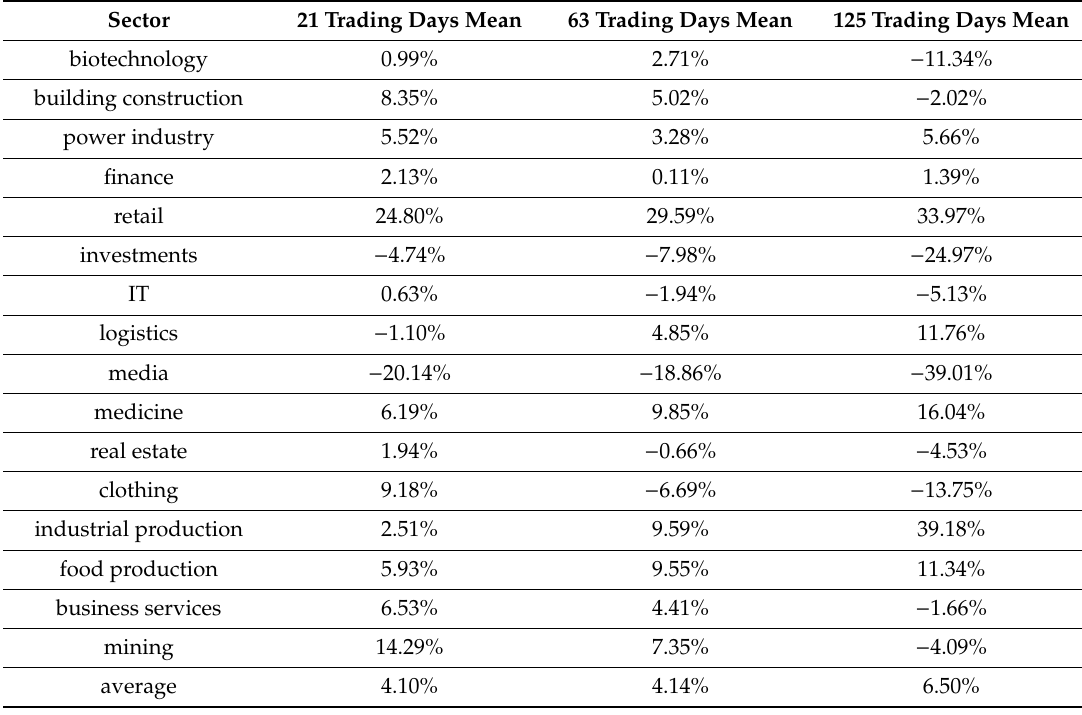
Table 6. Levels of discounts divided by